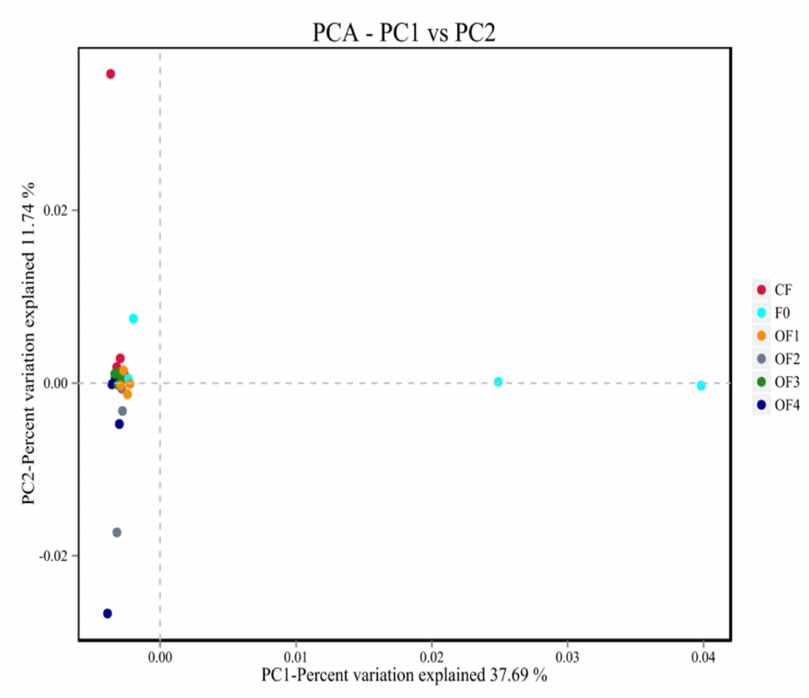
Figure 4. Principal coordinates analysis of soil fungal OTUs. F0, no fertilizer (F0); CF, con- ventional NPK fertilizer, OF1, biochar + conventional NPK fertilizer; OF2, seaweed bioorganic fertilizer + conventional NPK fertilizer; OF3, Jishiwang bioorganic fertilizer + conventional NPK fertilizer, OF4, attapulgite organic fertilizer + conventional NPK fertilizer. 3.4. Effect of Organic-Inorganic Fertilizers on Soil Fungal Community at Phyla and Class